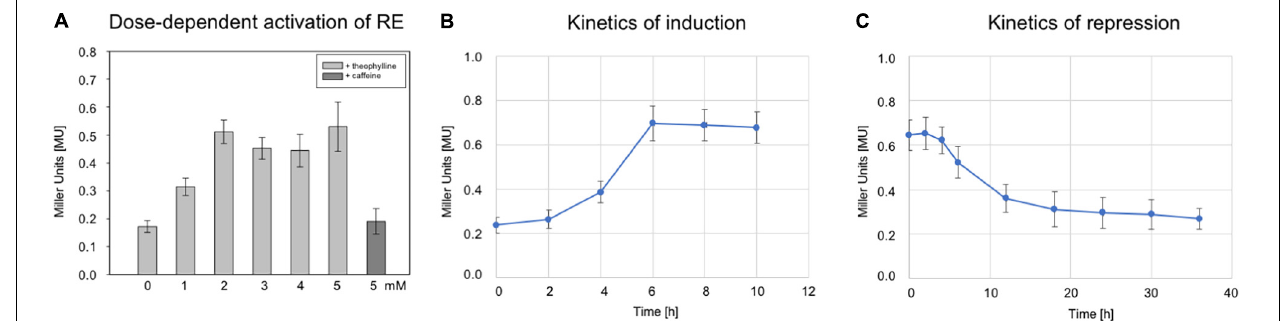
FIGURE 3 | Characterization of riboswitch E. (A) Effect of different theophylline concentrations on bgaH expression controlled by riboswitch E. Hfx. volcanii RE transformants were grown in the presence of 0, 1, 2, 3, 4, or 5 mM theophylline to OD 600 1.2 (3 M salt media, 37 ◦ C), and the BgaH activity was determined in Miller units. As a control, 2 mM caffeine was used instead of theophylline. The experiments were performed in triplicates on three different days. (B) The bgaH expression and BgaH activity after the addition of theophylline. RE transformants were cultured for 8 h (3 M salt media, 37 ◦ C) and then theophylline was added to a final concentration of 5 mM. The BgaH activity was quantified after 2, 4, 6, 8, and 10 h of growth. (C) Repression of bgaH expression by removing theophylline. RE transformants were cultured for 8 h at 37 ◦ C in 3 M salt media containing 2 mM theophylline. Incubation of cells was continued for 36 h without theophylline and the BgaH activity was quantified after 2, 4, 6, 12, 18, 24, 30, and 36 h of growth. Shown are the mean values and standard deviations of two independent measurements with three biological replicates each.